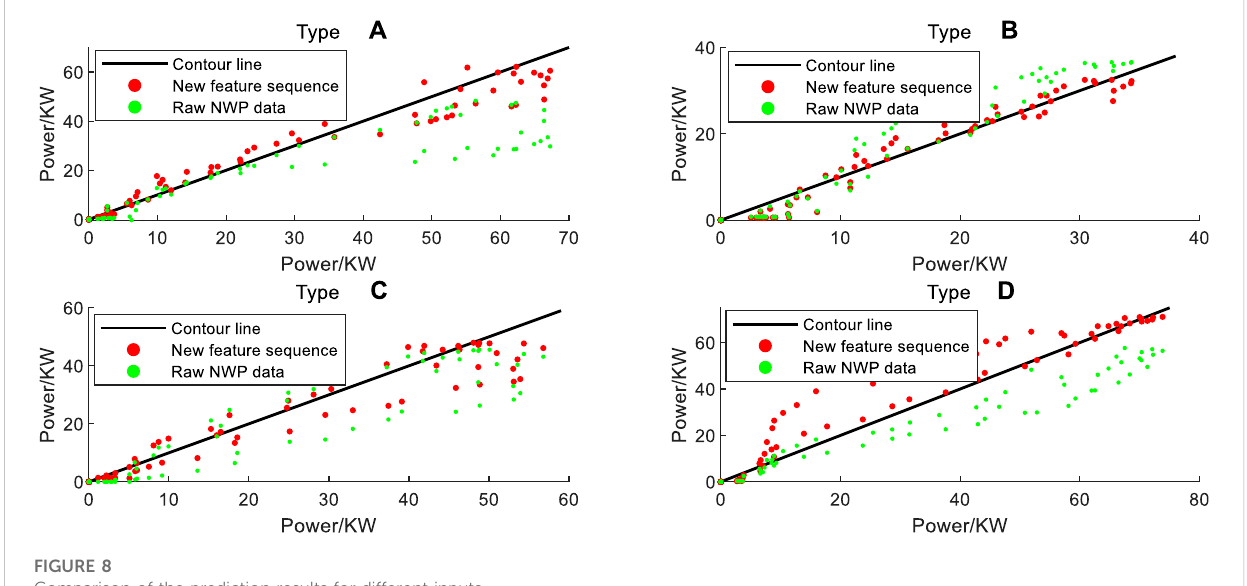
FIGURE 8 Comparison of the prediction results for different